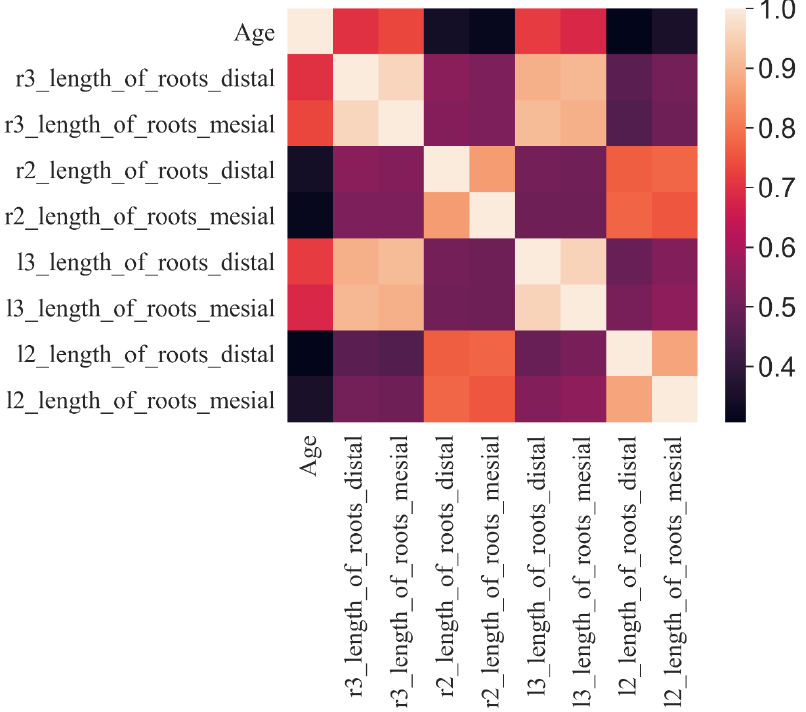
Figure 3. Heatmap representation of Pearson correlation among age groups and root lengths.